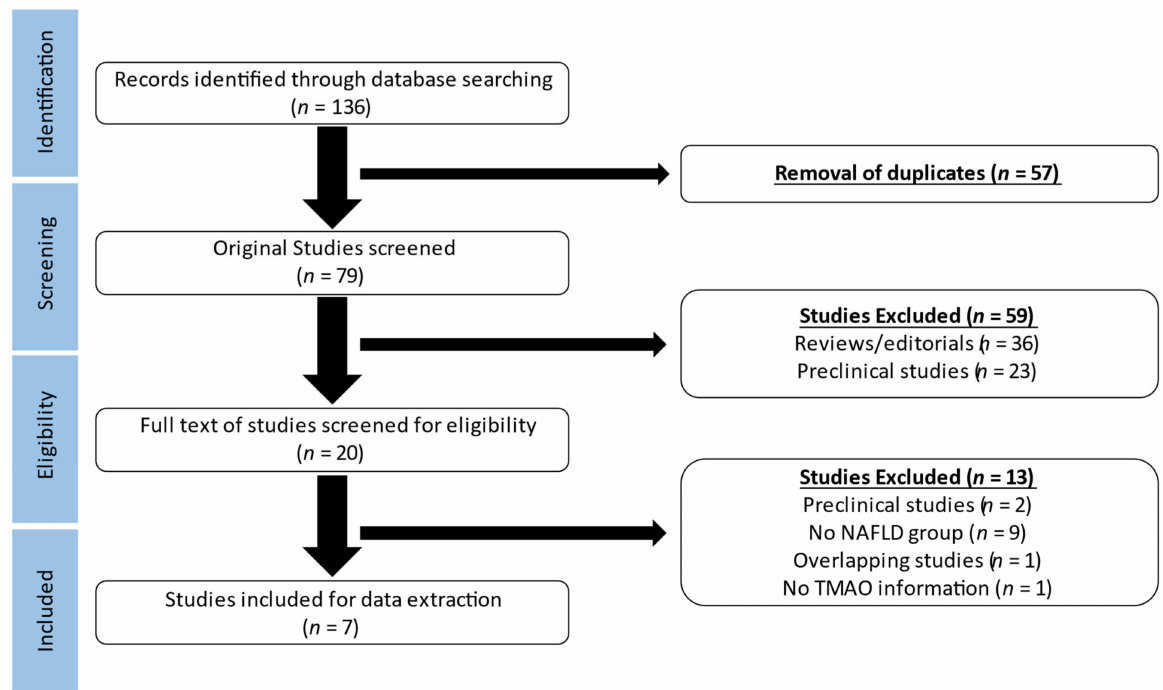
Figure 1. Preferred Reporting Items of Systematic Reviews and Meta-Analyses (PRISMA) flow diagram demonstrating the process of study selection in the meta-analysis. NAFLD: non-alcoholic fatty liver disease, TMAO: trimethylamine